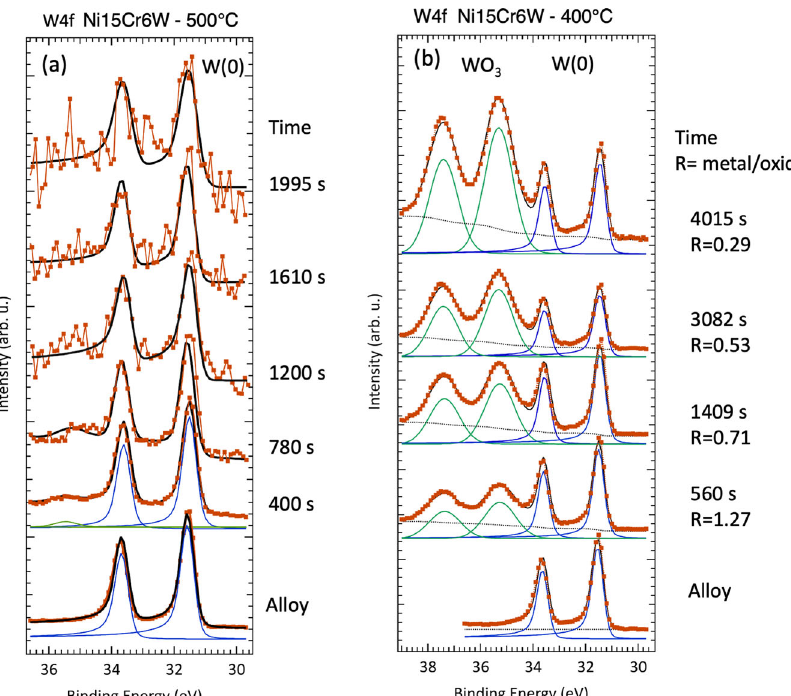
Fig. 6 Tungsten Contribution. W4f core level recorded during the oxidation of Ni-15Cr-6W at ( a ) 500 °C, and ( b ) 400 °C. The experimental spectra are marked with a red line-symbol, and the fi t envelope is a black line. The W metal (blue line) and oxide signals (green line) are separated with a fi t. The respective time since start of oxidation is given on the right hand side of each graph, and ( b ) includes the metal/oxide ratio. The oxide contributions in ( a ) is below